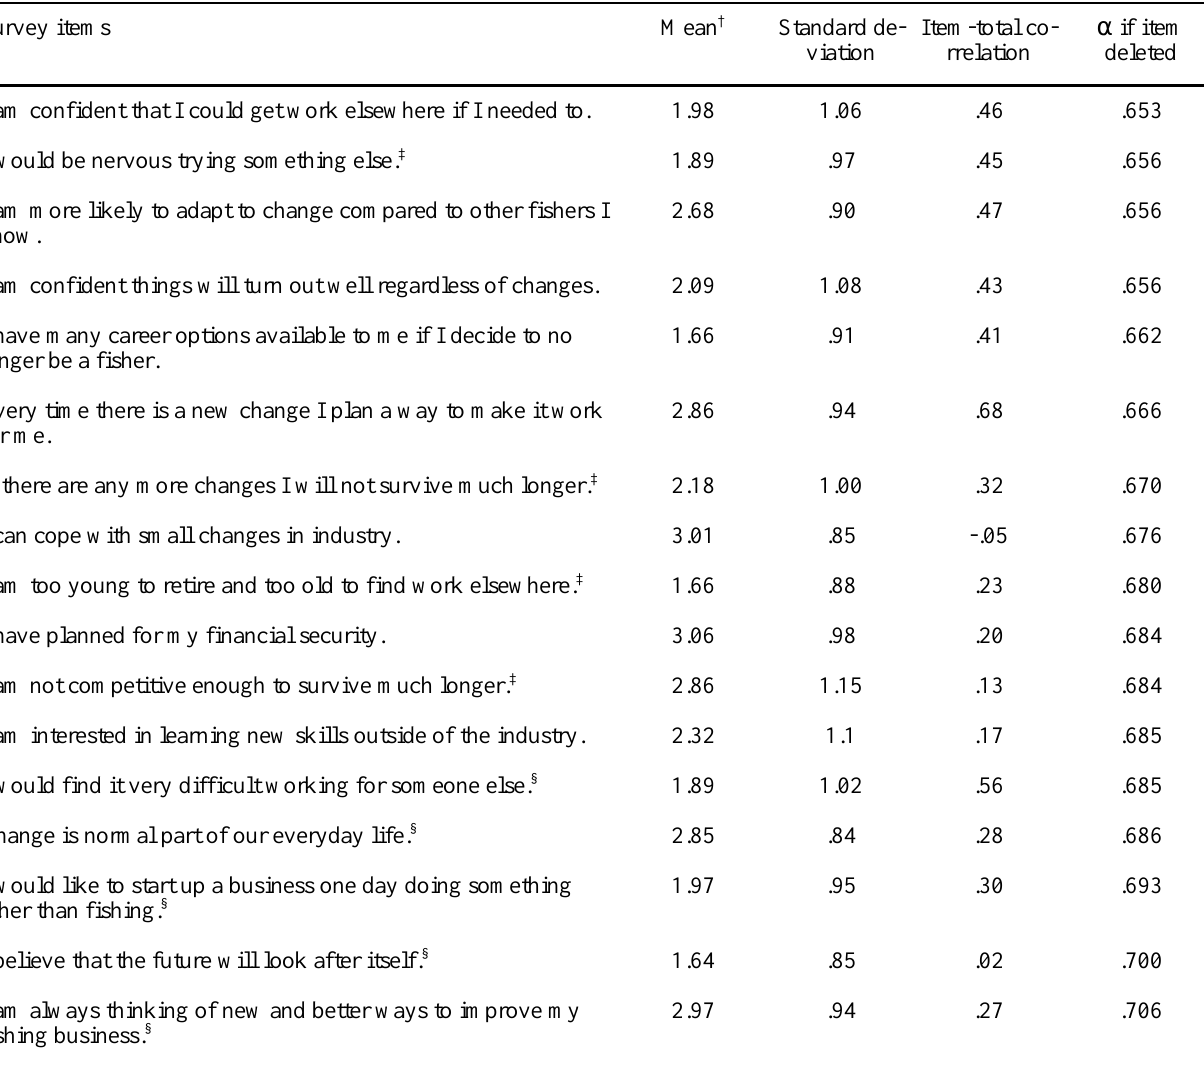
Table 1 . Descriptive statistics and reliability analysis for the response of the sample of commercial fishers to each survey item;